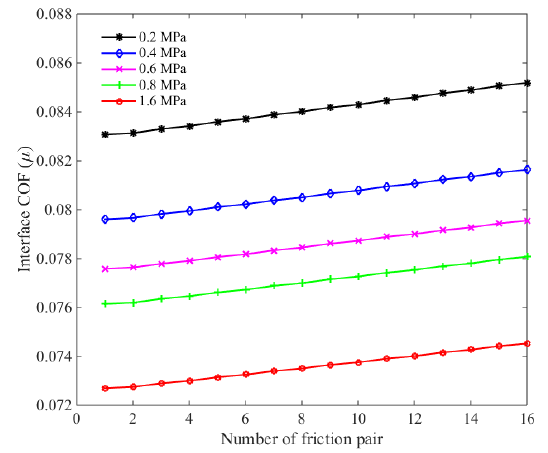
Figure 6. Variation of the interface COF regarding the friction pairs.